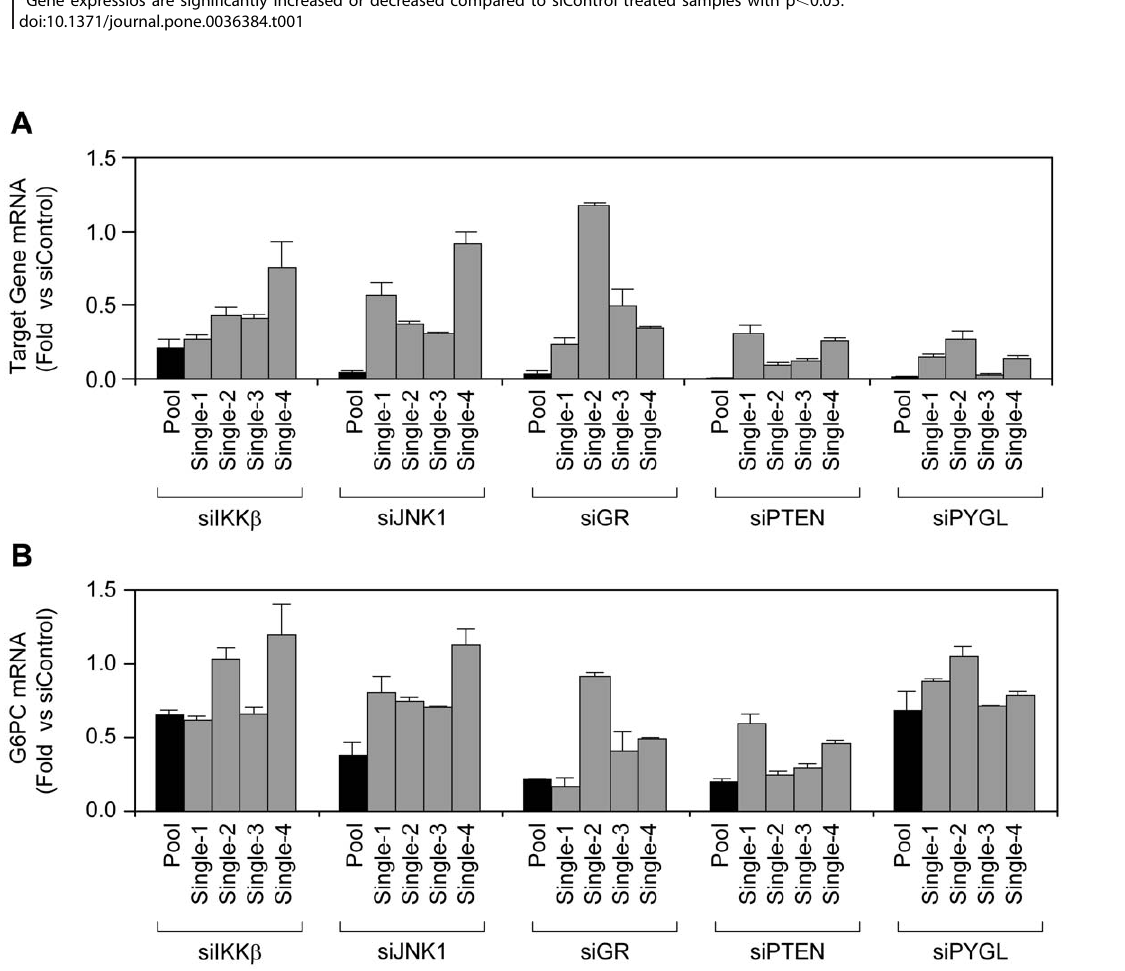
Figure 3. Pooled siRNAs demonstrate greater knockdown efficacy than single siRNAs. Comparison of the ability of transfected pooled vs. single siRNAs to A. knockdown target gene mRNA levels and B. reduce G6PC mRNA levels in AH-G6PC cells incubated with Dex/cAMP and 10 nM insulin for 6 h. Black bars are pooled siRNA samples; grey bars are single siRNA samples. Data are presented as fold changes relative to mRNA expression in siControl-transfected cells and are the means of 3 independent experiments for A and B. doi:10.1371/journal.pone.0036384.g003 PLoS ONE |